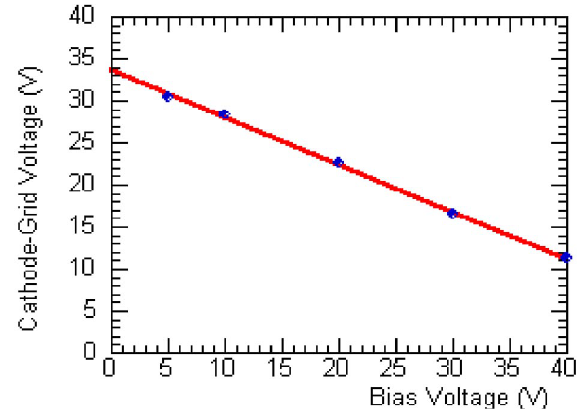
FIG. 14. (Color) Mean beam energy at different bias voltages (solid line is fitting line using experimental data shown as dots).